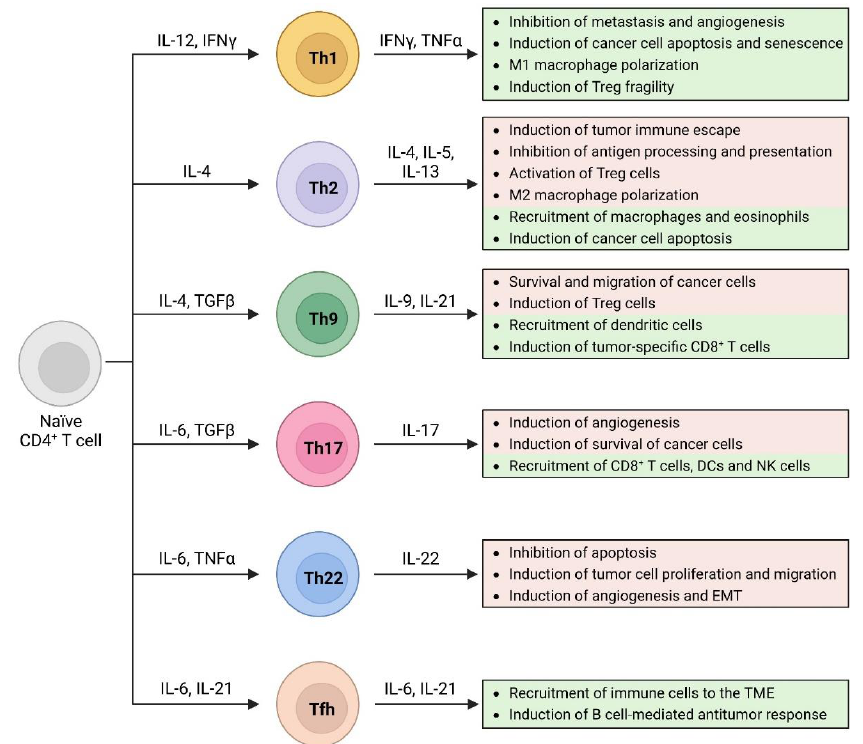
Figure 1. CD4 + T helper subsets and their functions in the antitumoral immune response. Depending on the cytokine milieu, naïve CD4 + T cells differentiate into different T helper subsets with different